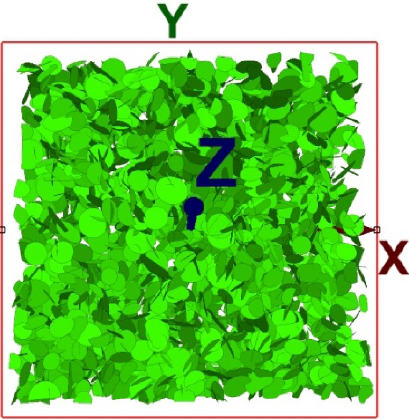
Figure 14. Model of the natural weakness plane.